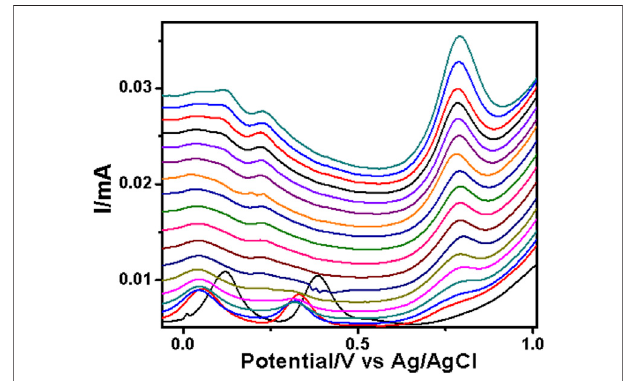
FIGURE 5 | SWV analysis of the sulfadiazine at the PAA nano fi ber – modi fi ed screen-printed electrode (SPCE) in 0.1 M Tris – HCl with concentrations ranging from 25 to 250 µM at 50 mVs.